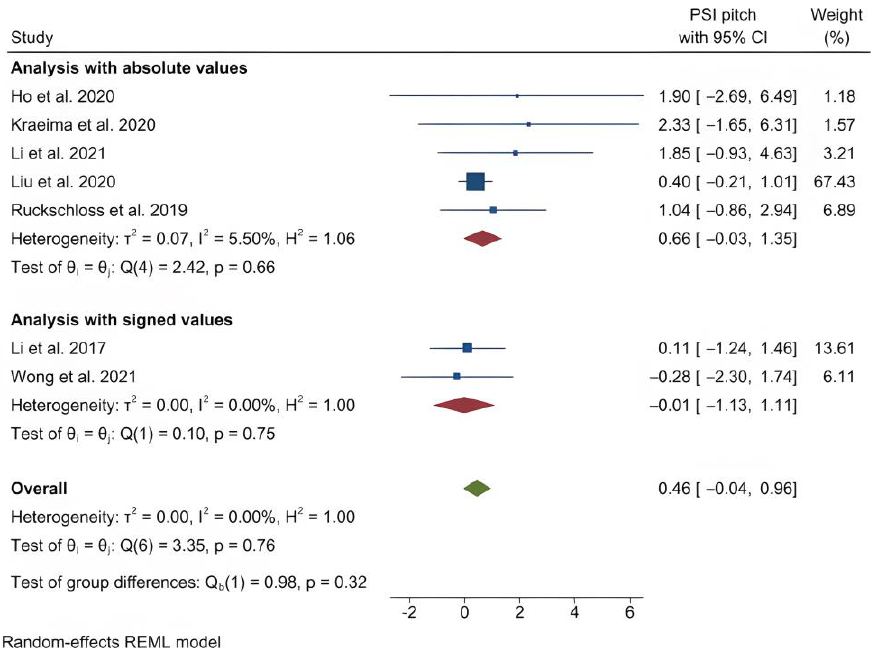
Figure 5. Forest plot showing mean vertical deviation.